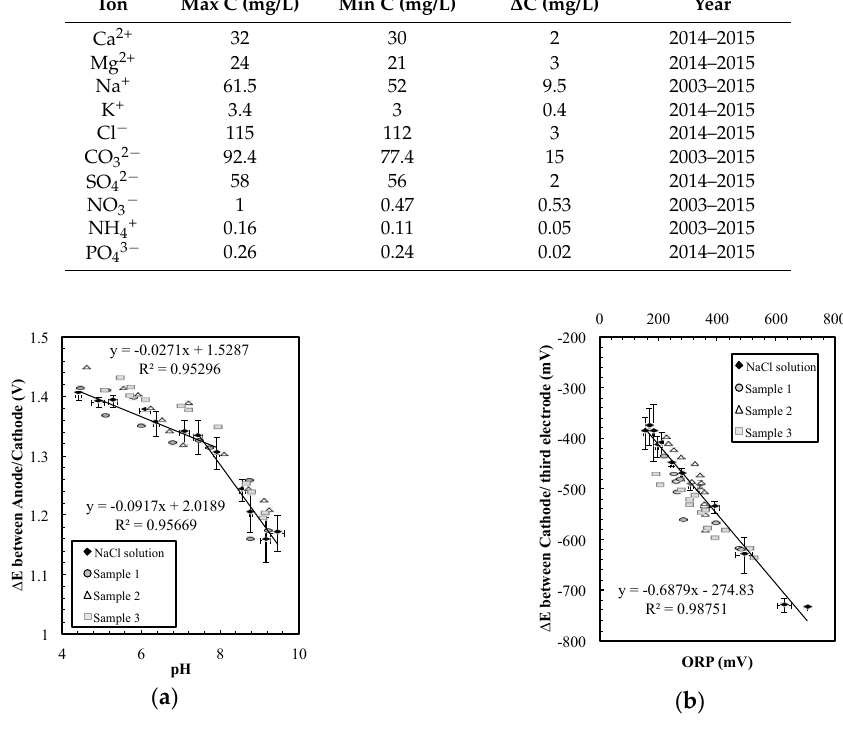
Figure 5. ( a ) The pH measurement and ( b ) the ORP measurement in the water